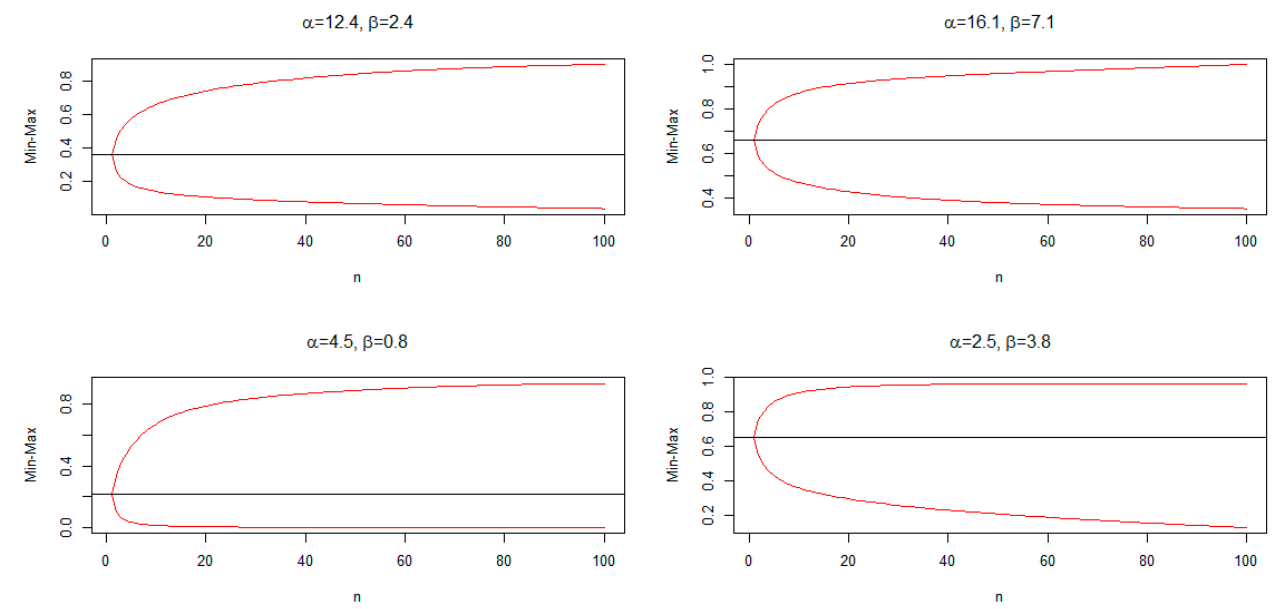
Figure 4. Min-max plots for the AP distribution.